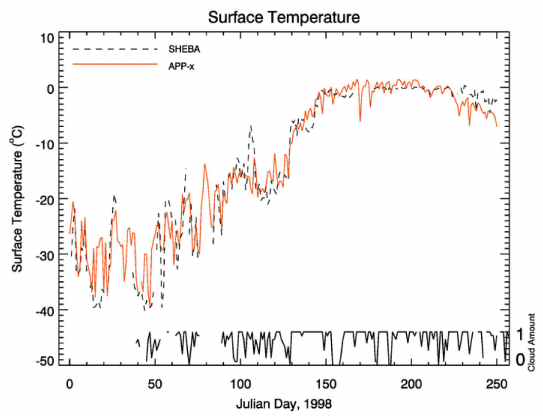
Figure 7. Comparison of satellite-derived and surface measurements of the surface skin temperature during SHEBA. Cloud amount is also